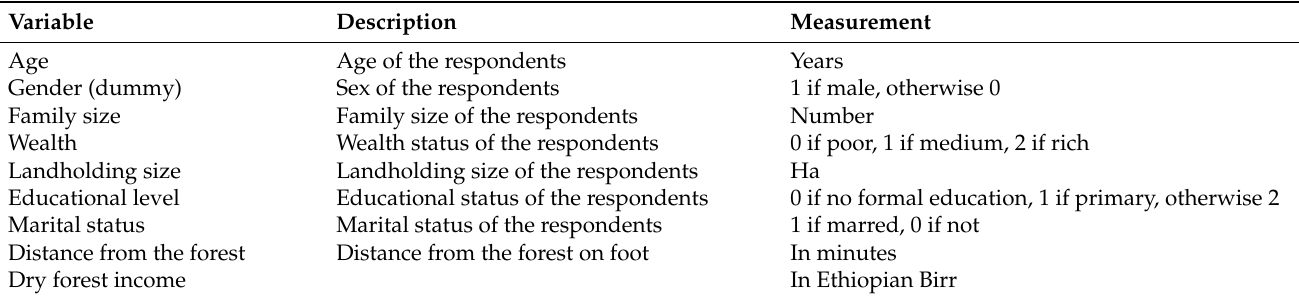
Table 1. Explanatory variables included in the logistic regression